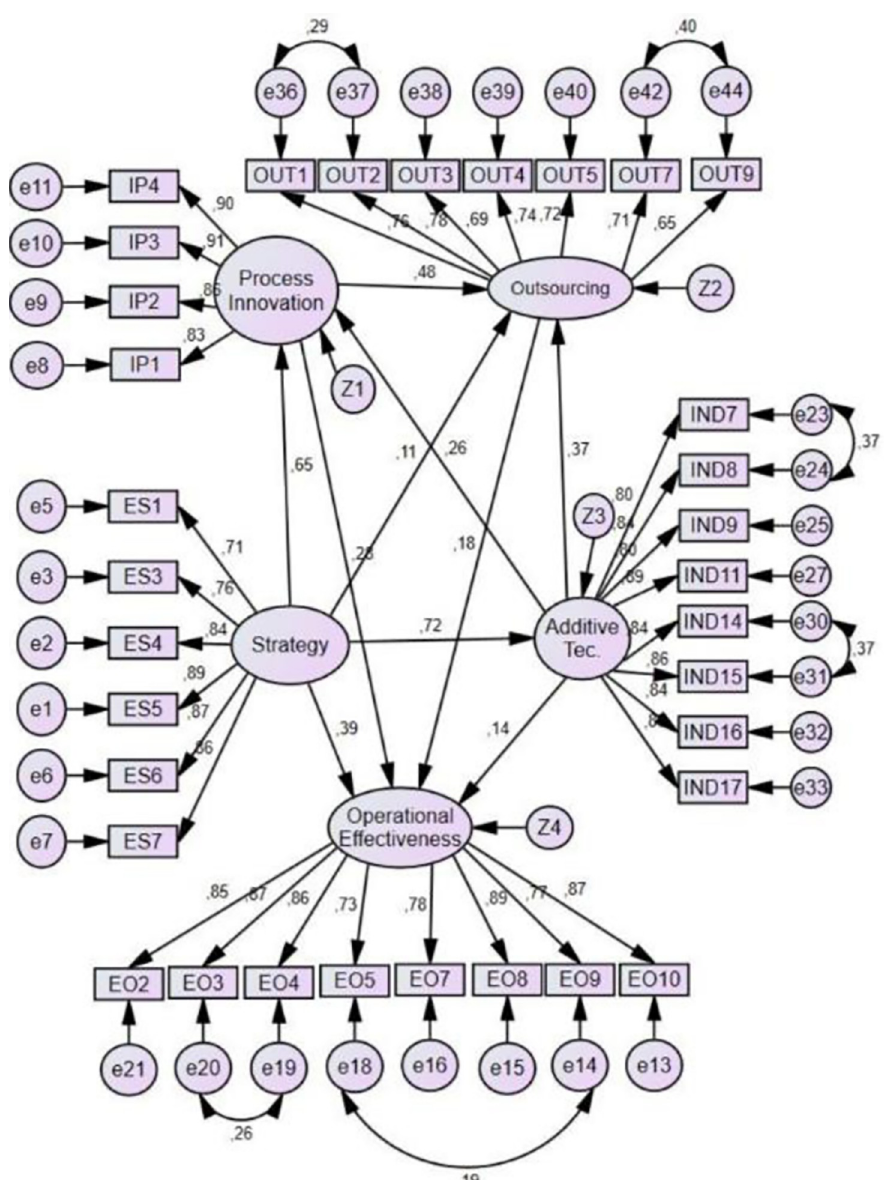
Fig 4. Model results. Source: By the